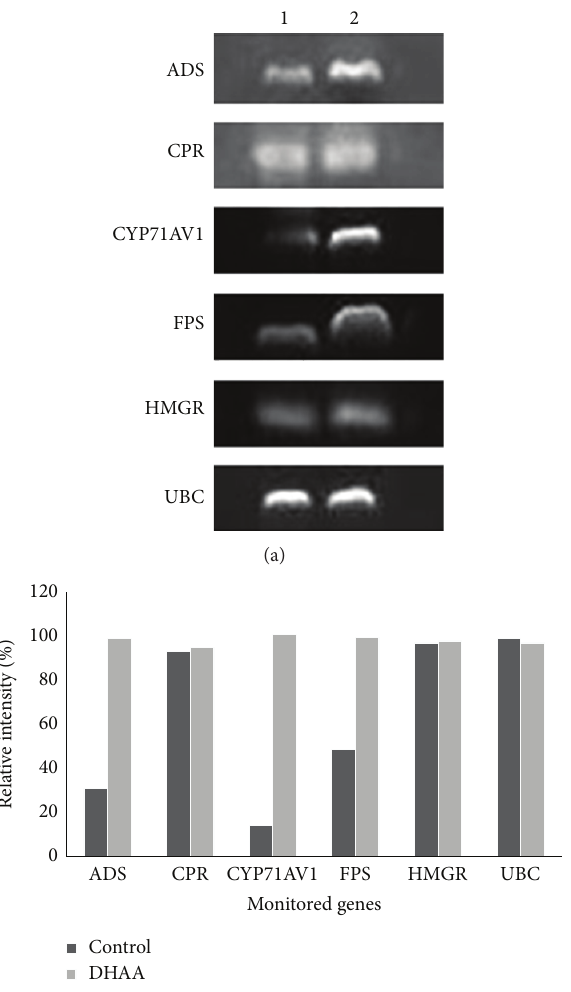
Figure 5: Effect of DHAA on the transcript levels of ADS, CPR, CYP71AV1, FPS, and HMGR genes in suspension-cultured cells of A. annua . (1): control group; (2): DHAA (25 mg/L) treated group, UBC was used as the internal standard. The band intensities were quantified by Image J software, and the relative expression was the ratio of intensity of control group to that of DHAA